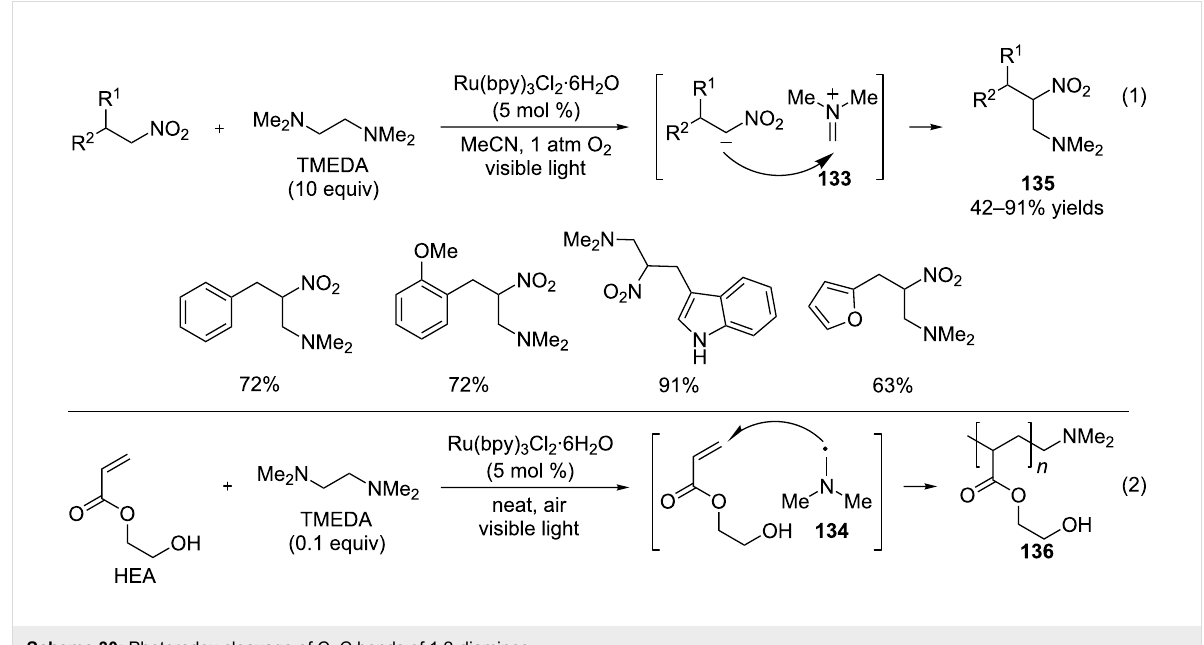
Scheme 30: Photoredox cleavage of C–C bonds of 1,2-diamines.